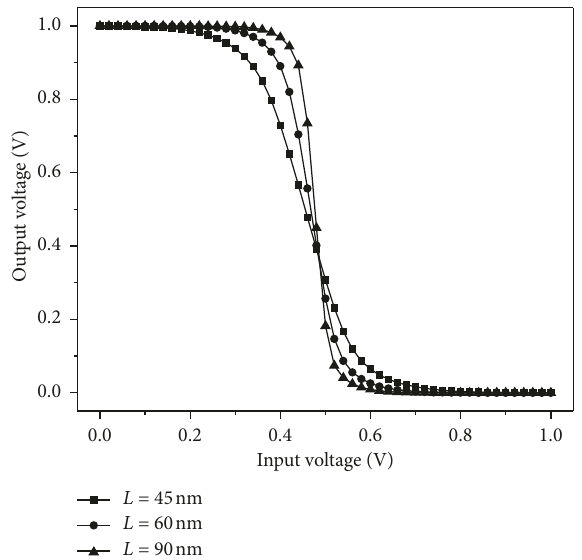
Figure 18: VTC curve of pseudo-NMOS for TMG Re-S/D FD SOI MOSFET at different channel lengths.